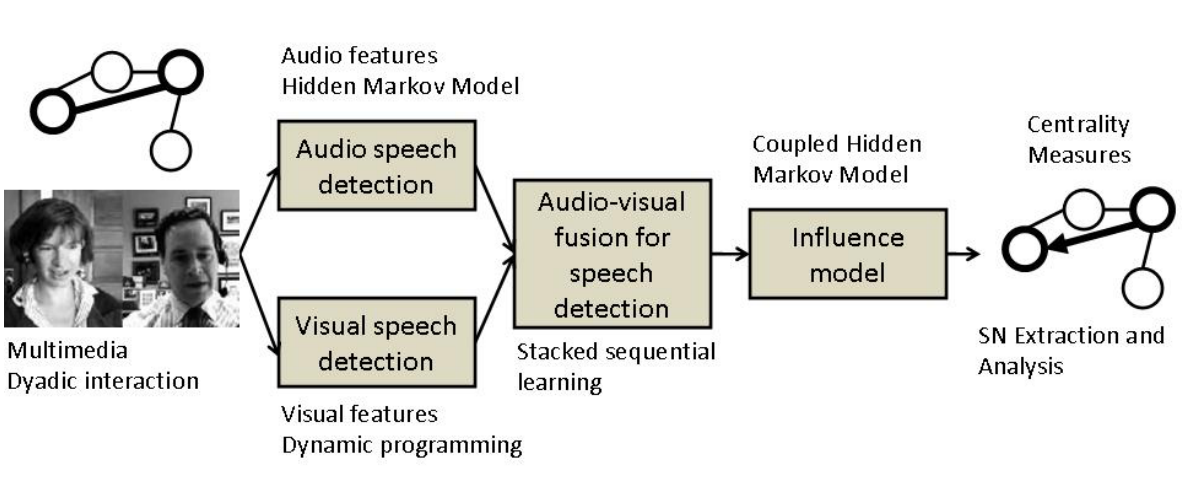
Block diagram of our integrated framework for Social Network extraction and